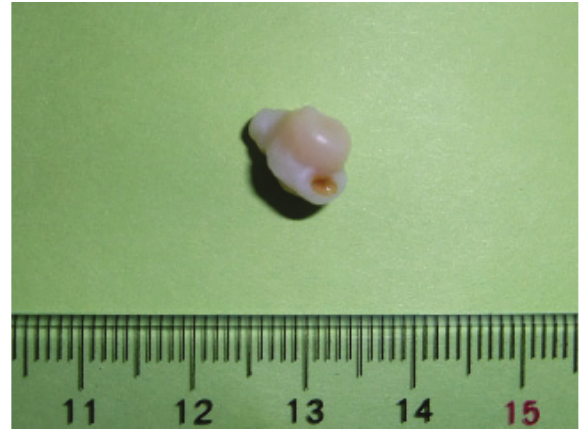
Figure 1: Photograph of hydrocele stone.